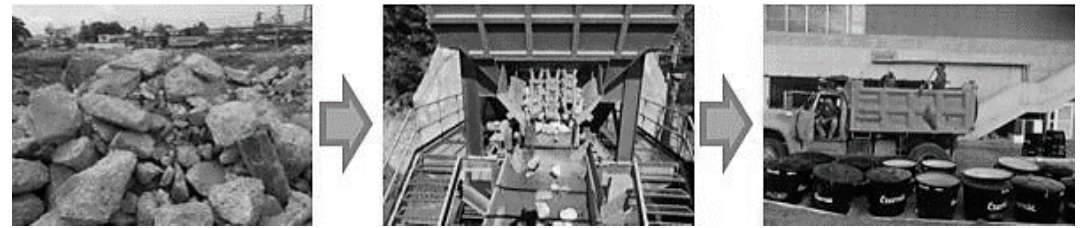
Figure 3. Crushing processes to obtain the RCA.